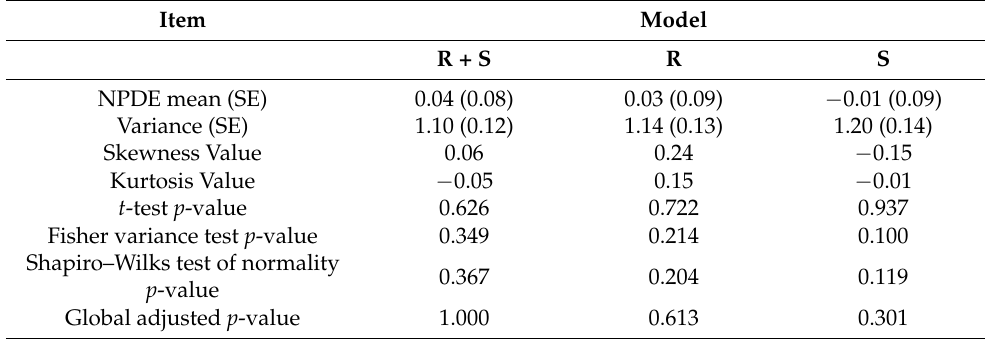
Table 4. NPDE results of the final model.